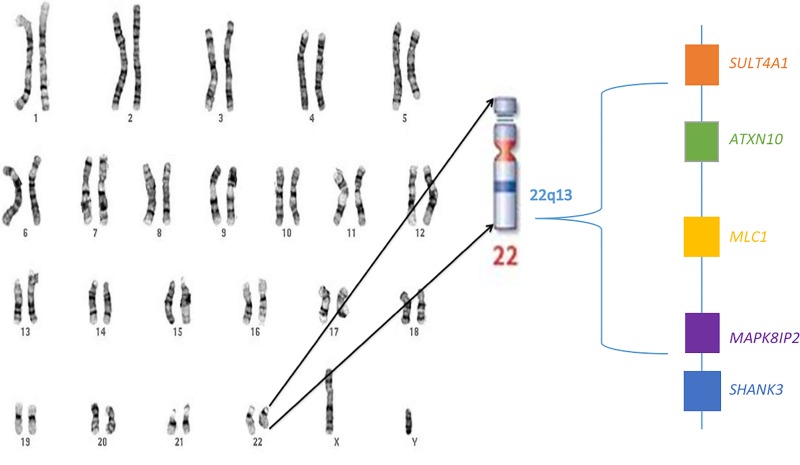
22q13 region.The location of the highest expressed genes in relation to SHANK3 is shown.